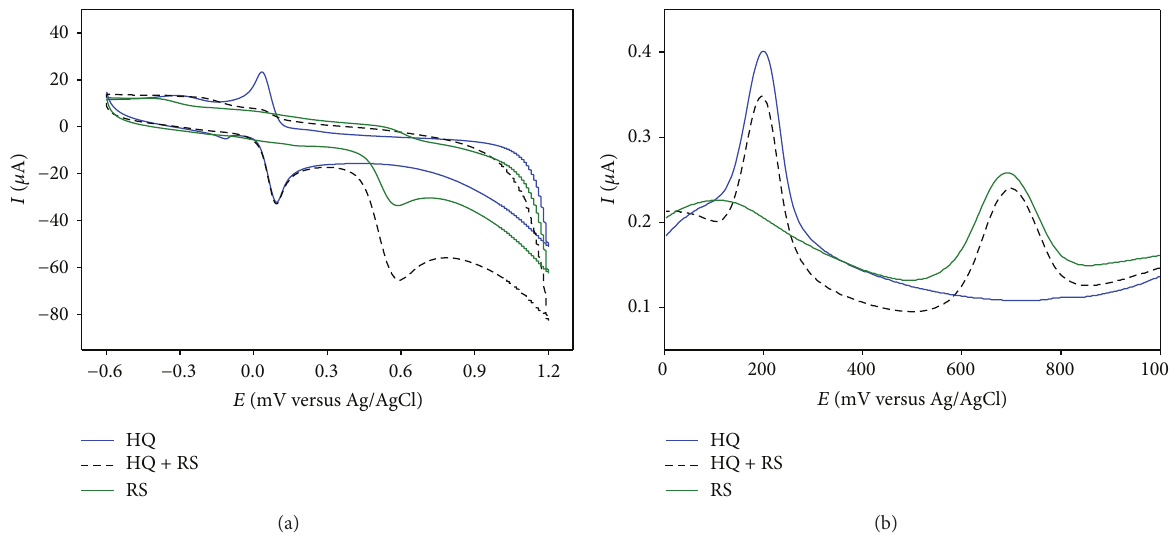
Figure 4: Overlay of (a) CV and (b) DPV responses of individual (solid lines) and mixture (dashed line) of HQ and RS in PBS at PGA modified GCE.